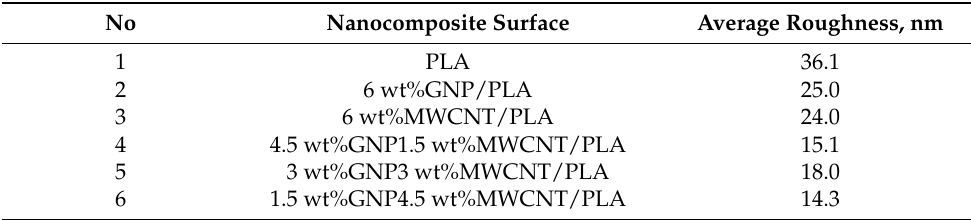
Figure 6. Remnant track depths of nanoscratches performed over monofiller and bifiller composite samples including pure PLA as reference. Table 1. Average surface roughness received by in-situ SPM imaging of nanocomposite surface area subjected to nanoscratch